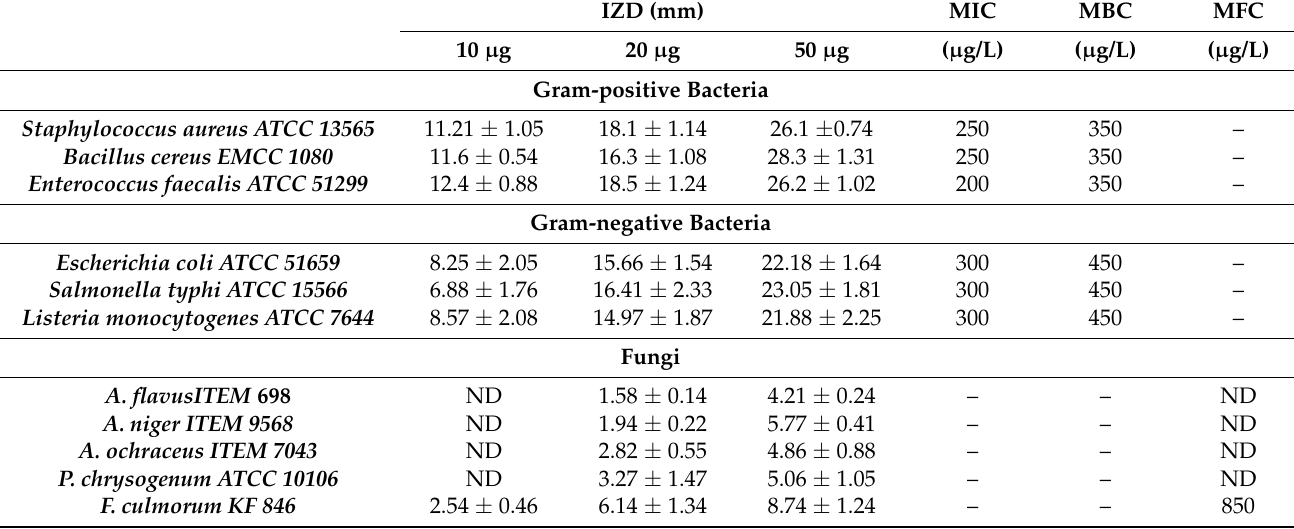
Table 2. Antibacterial and antifungal properties of Agaricus blazei extract.